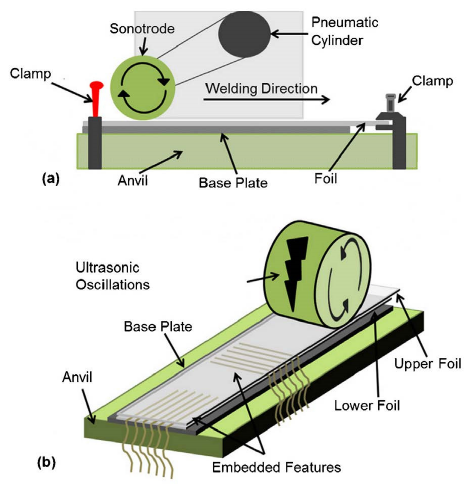
Figure 5. ( a ) Front view and ( b ) embedding features of ultrasonic consolidation process [40].